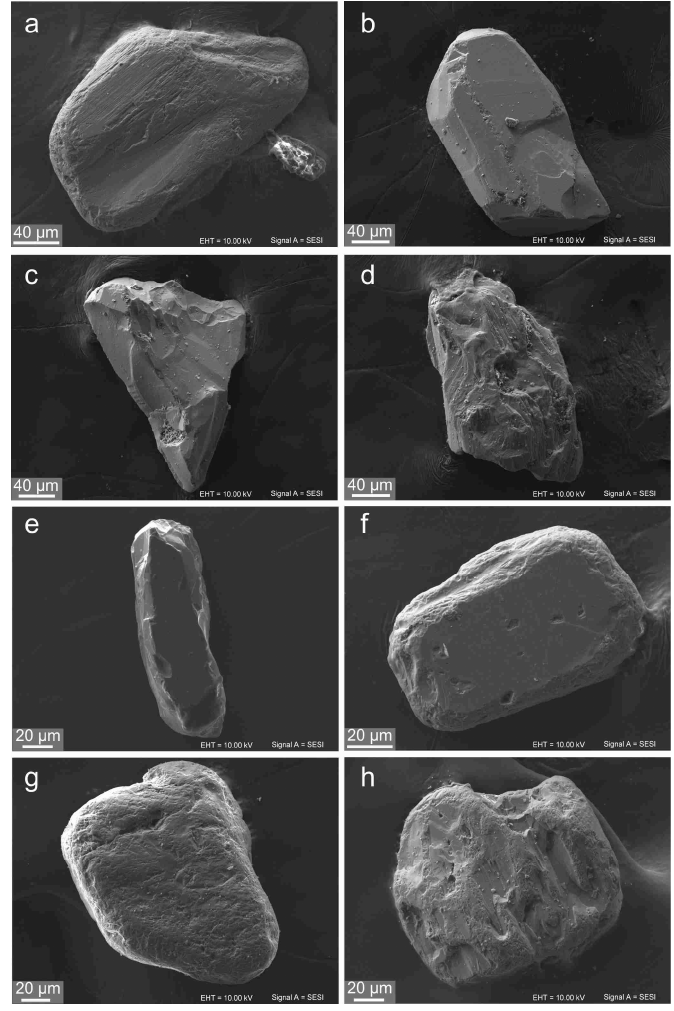
Figure 3. SEM images of detrital rutile grains showing different stages of abrasion and weathering. ( a ) Rutile crystals from Glanów-Stroniczki (GLA) with visible chemical weathering marks; ( b – d ) grains from Bolmin (BOL) showing different stages of weathering from pristine crystals without traces of weathering ( b ); grain with fresh cracks without weathering ( c ); to highly altered crystal with visible etchings ( d ); ( e , f ) rutiles from borehole Ł uków IG-1 (sample LK), needle-like rutile crystal ( e ) does not show any sign of alteration apart from physical weathering, ( f ) rutile is altered and rounded by weathering (chemical and physical); ( g , h ) altered and chemically weathered rutile from borehole Tomaszów Lubelski IG-1 (sample TL).